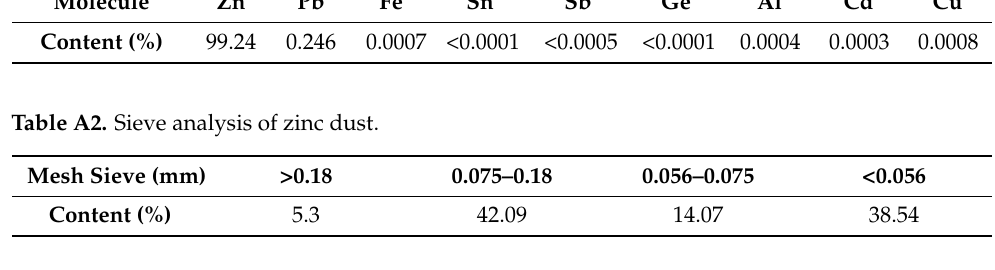
Table A3. Chemical analysis of the sifted zinc ash (SZA) and zinc ash (ZA).